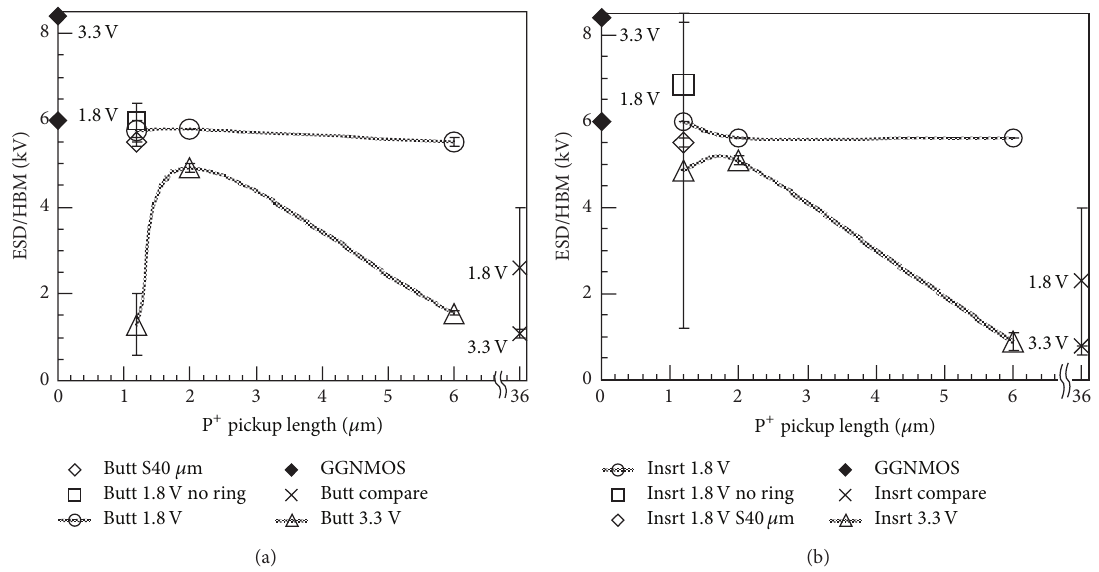
Figure 6: (a) The ESD/HBM failure threshold versus pickup length comparison among the normal GGNMOS and various butting pickup conditions. (b) The ESD/HBM failure threshold versus pickup length comparison among the normal GGNMOS and various inserted pickup conditions.